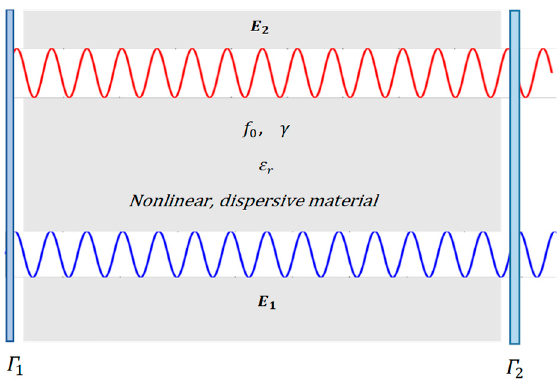
Figure 2. Concurrent propagation of the stimulus and the pump waves in a micro-resonator.